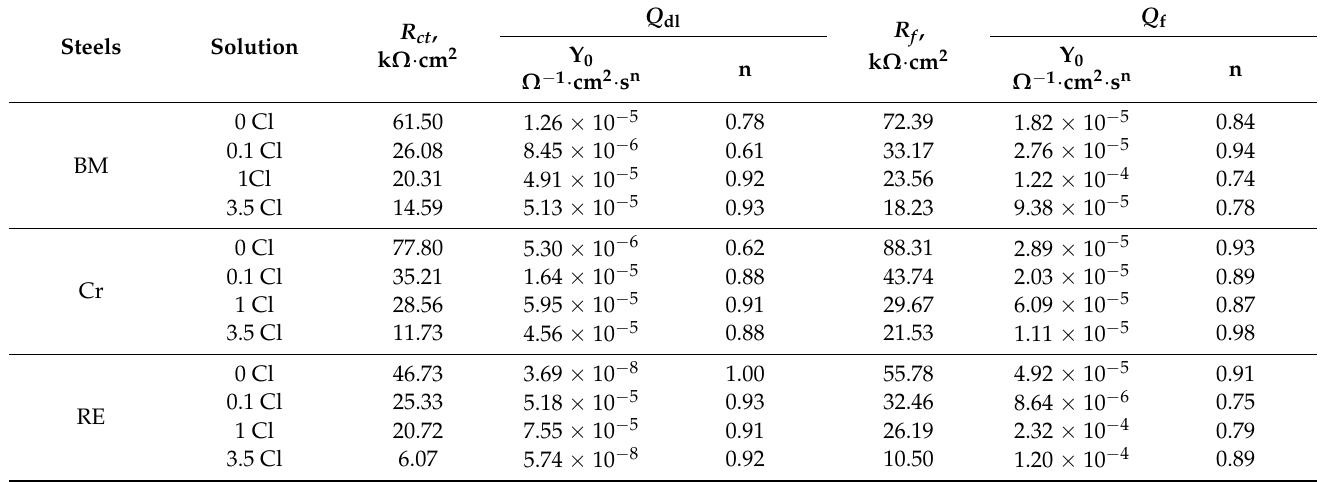
Table 1. Fitted results of EIS data for the passive film on steel